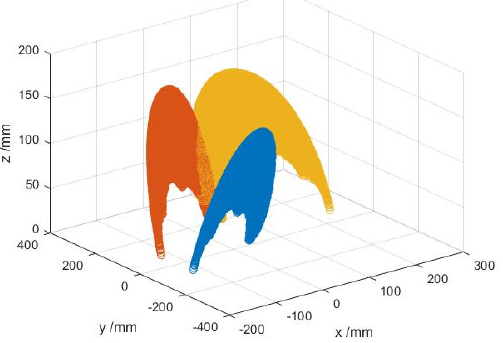
Figure 19. Three-dimensional workspace of fingertips in the coordinate system of the palm.